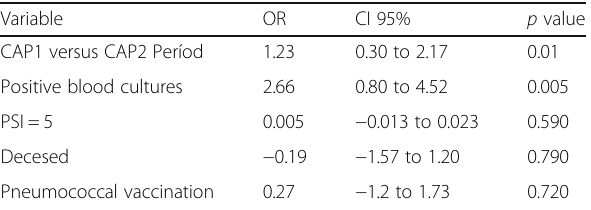
Table 4 Conditional Logistic Regression model for matched cases and controls, Multivariate Analysis, showing that regardless of PSI class = 5, having received pneumococcal vaccine, and age (in addition to all the variables by which the individuals were matched), the only two factors that increased the chance of having positive SPUAT were belonging to the CAP1 (OR 2.66) cohort and having positive blood cultures (OR